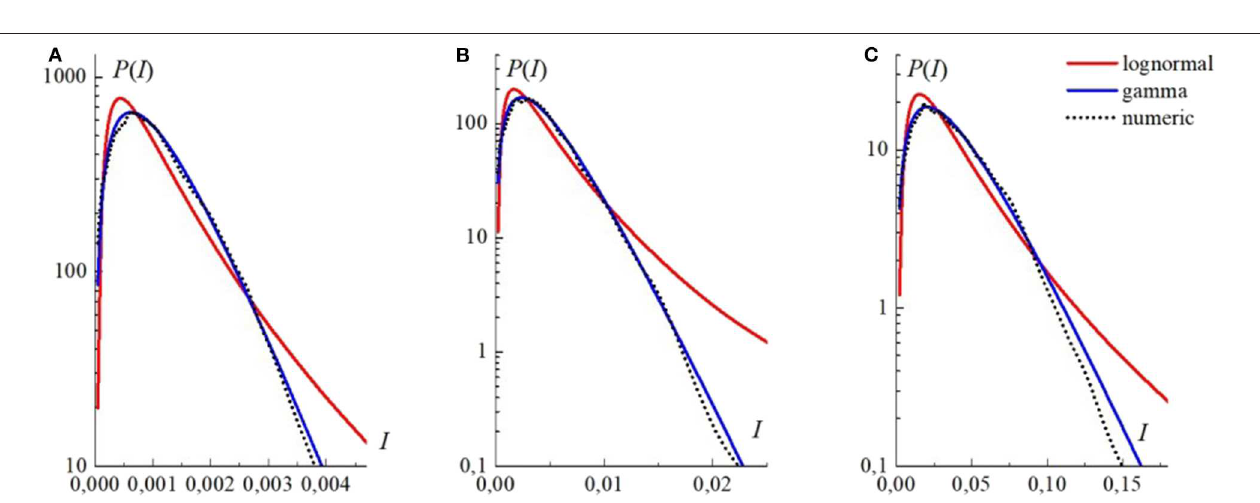
FIGURE 12 | Probability density functions (PDFs) of intensity fluctuations (solid curves) (A) at the axis ( r the average intensity distribution of the Laguerre—Gaussian beam, and (C) at the peak point ( r σ I ( r ) 0.30 σ I ( r ) 0.31, respectively. Here, l = = dashed curve corresponds to the gamma distribution [32].